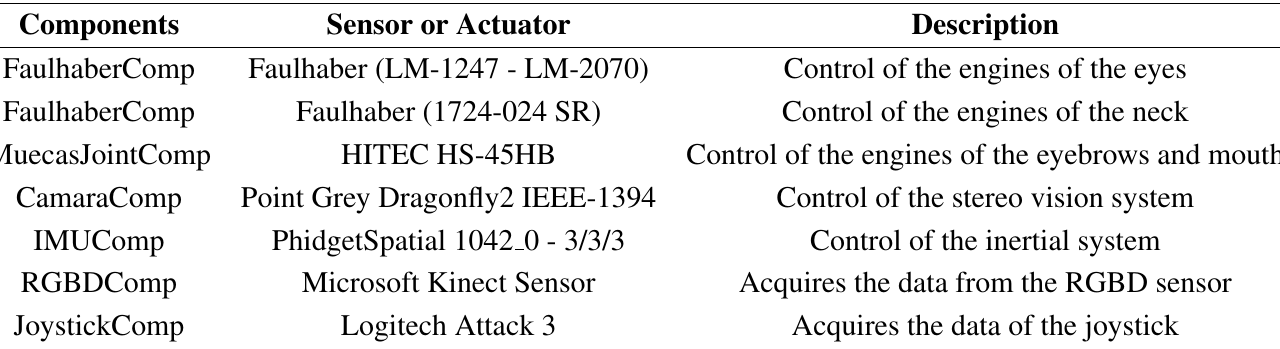
Table 2. Software components, sensors and actuators of the multi-sensor robotic head.